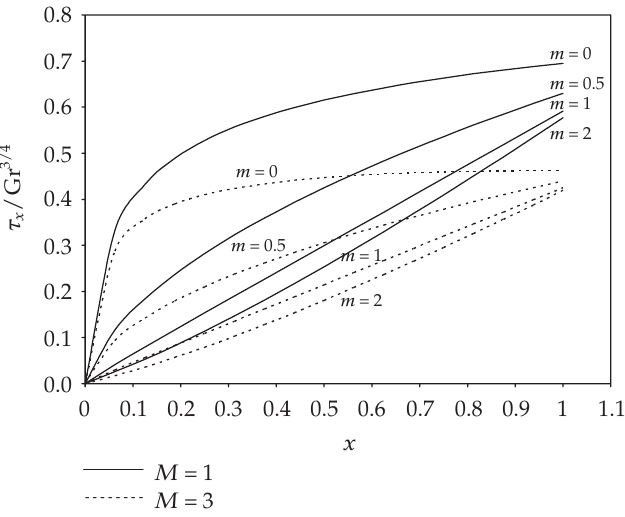
Figure 5.15 . The e ff ect of M and m parameters on local skin friction at F = 0 . 01 and Pr = 0 .